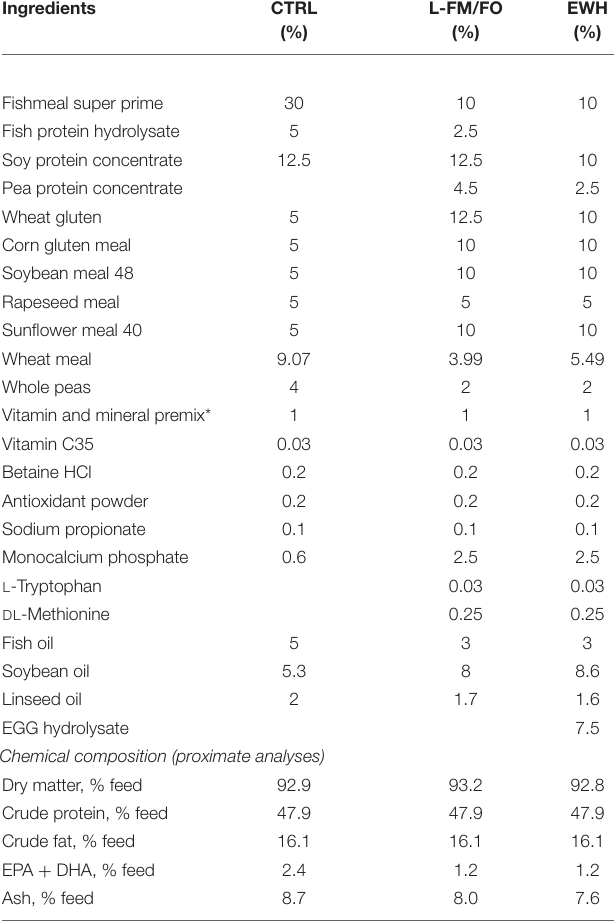
TABLE 1 | Ingredients and chemical composition of control and experimental diets.